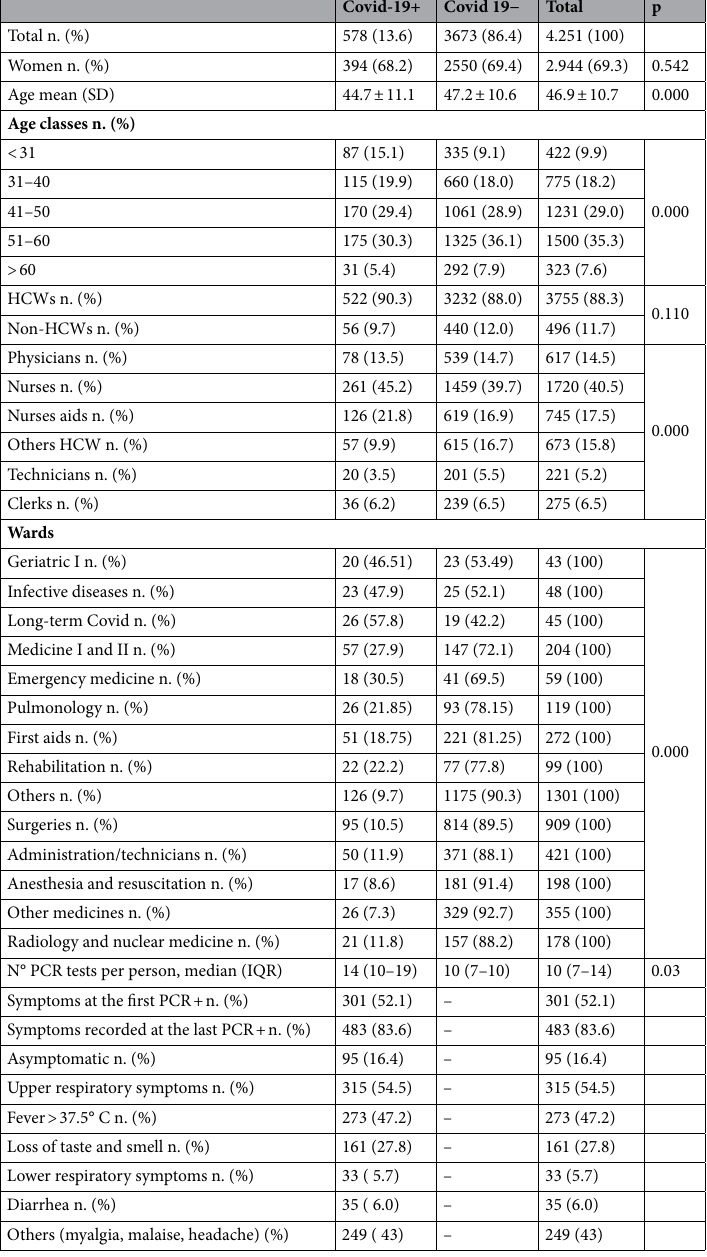
Table 1. Characteristics of the population studied and acquired COVID-19 infection from March 1, 2020 to February 28,